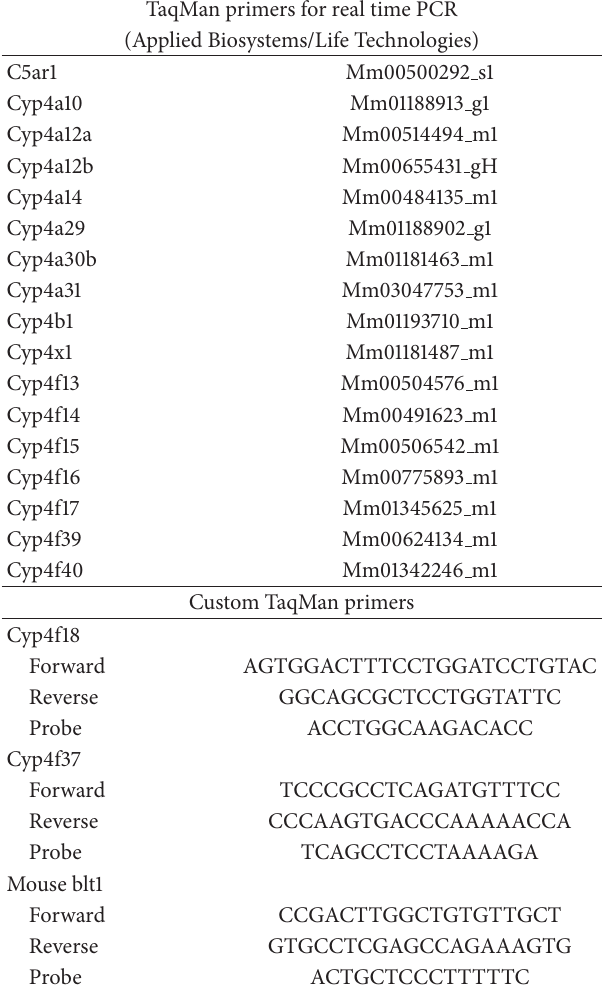
Table 1: Summary of